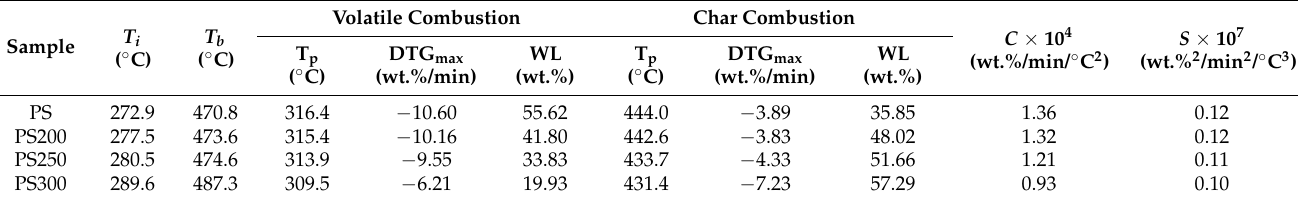
Table 1. Combustion characteristics and indices of the raw and torrefied